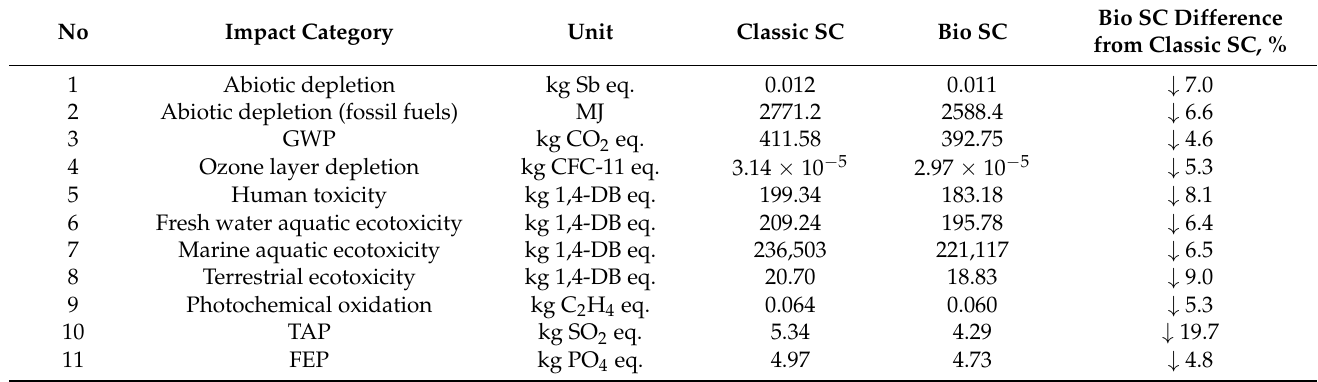
Table 3. Results of holistic cow management and milk production (for FU = 1000 kg of milk).